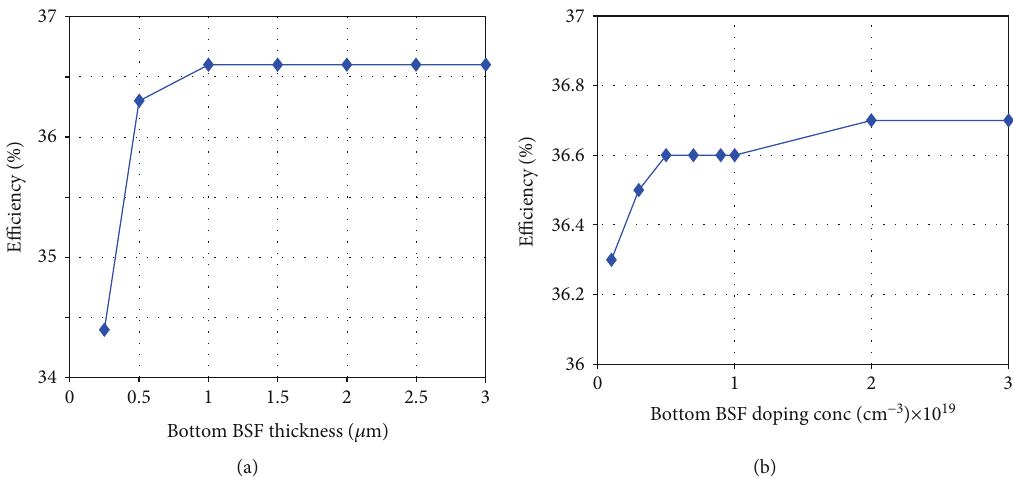
Figure 5: Optimization of the bottom BSF parameters. (a) Cell e ffi ciency vs. thickness. (b) Cell e ffi ciency vs. doping concentration.